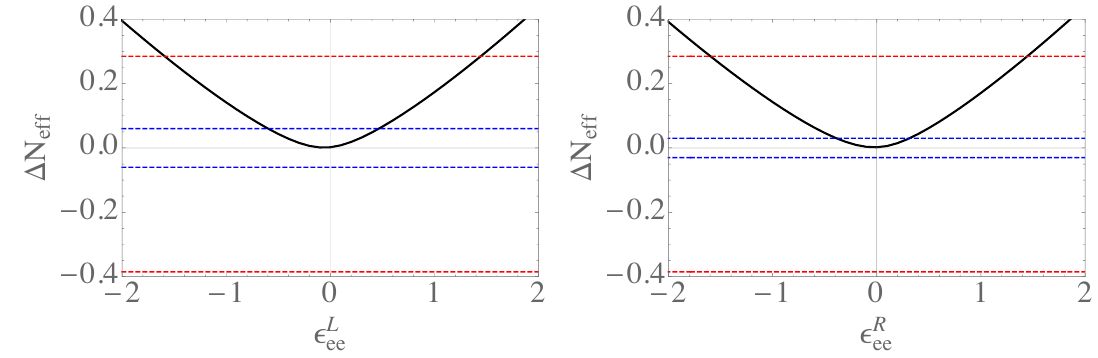
Figure 4 . Constraints on (cid:15) e,L (left panel) and (cid:15) e,R (right panel) from N eff . The black curves stand for corrections to N from the dimension-6 NC NSI operators, and the colorful lines are the same eff as those in figure 2. See more details on the notations used in these two